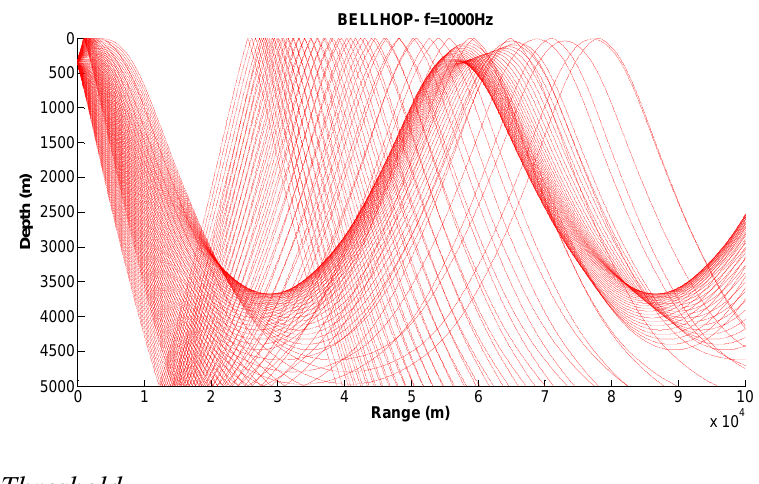
Figure 12. Corresponding ray trace for a source depth of 350